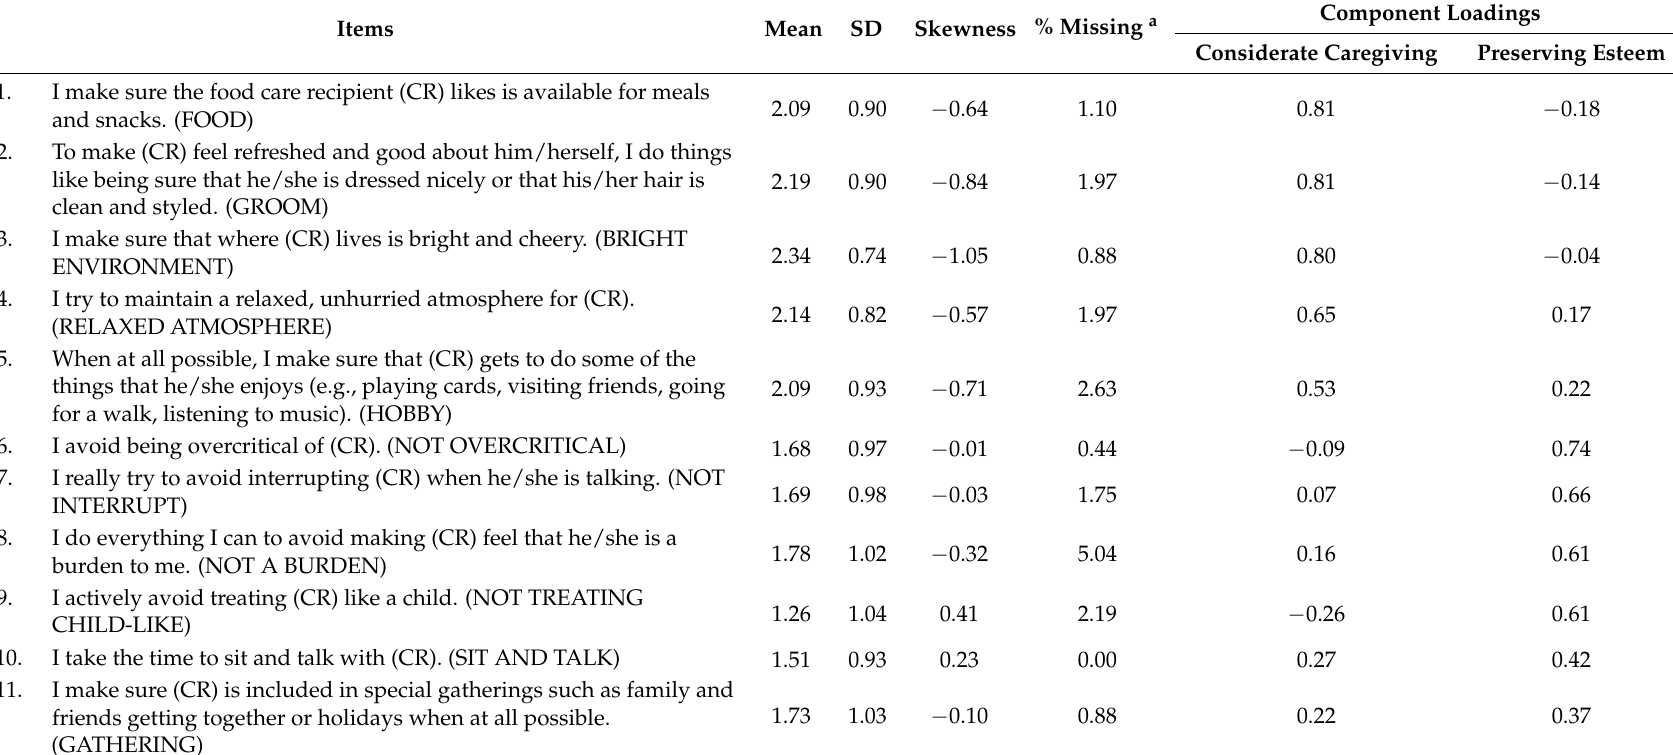
Table 2. Descriptive statistics of Exemplary Care Scale (ECS) items and component